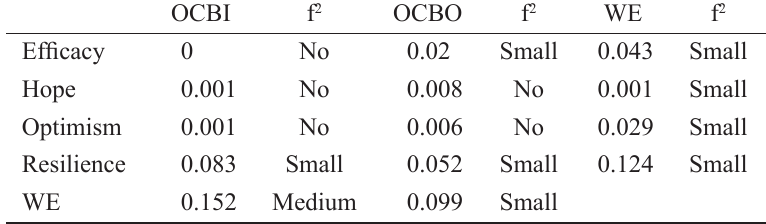
Effect Size (f 2 )